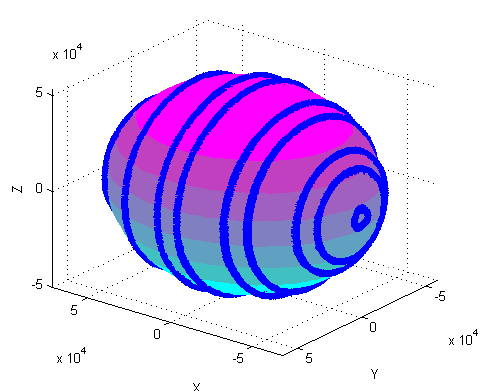
Figure 10. Optimal ellipsoid fitting (EF7). Figure 11. Optimal ellipsoid fitting (EF8).